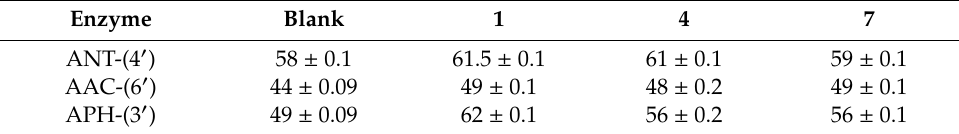
Table 2. Tm values of resistant enzymes with and without kanamycin A ( 1 ), neamine ( 4 ) and compound 7 .